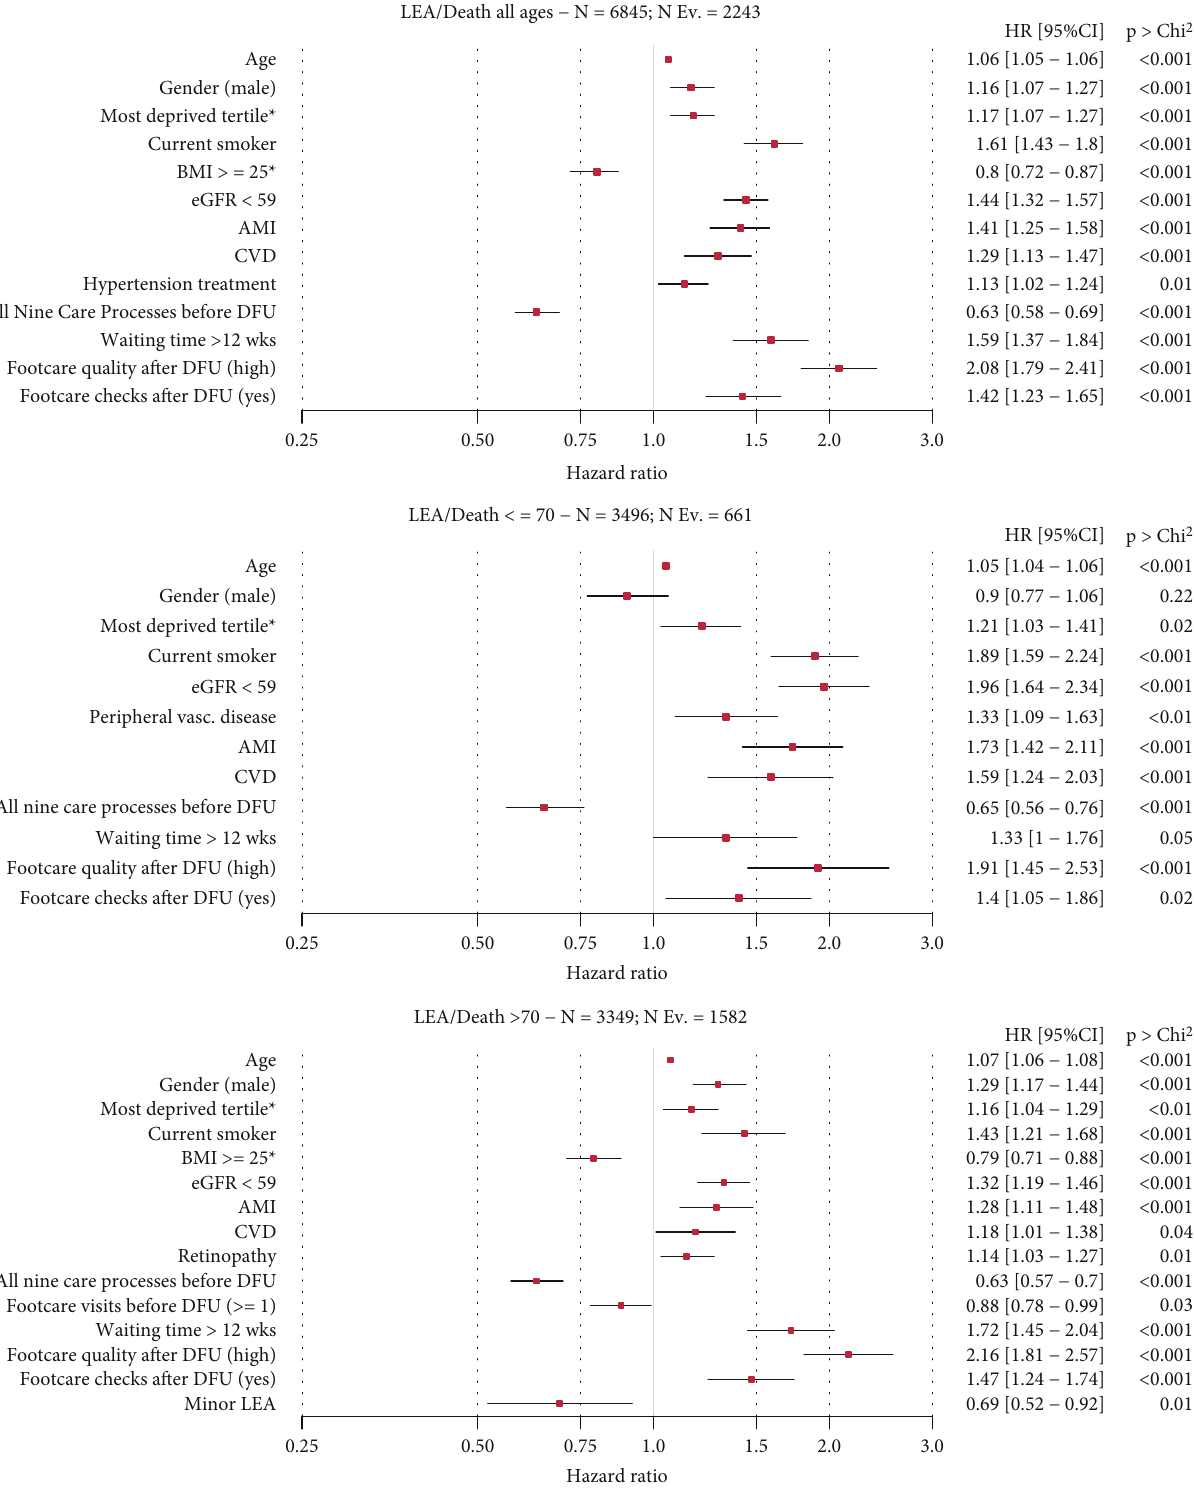
Figure 2: Multivariate analysis for amputation-free survival